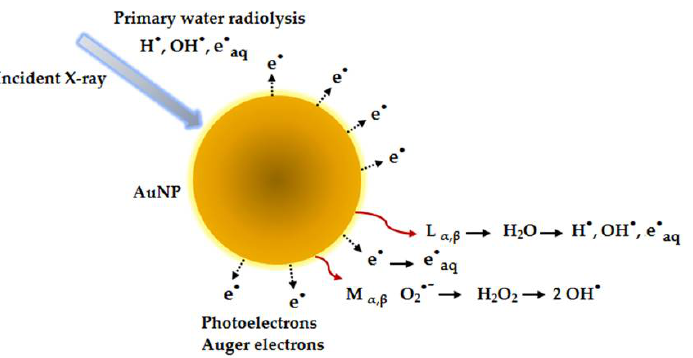
Figure 8. Schematic depiction of increased generation of reactive species by the emission of photo- electrons and Auger electrons from AuNPs in the presence of ionizing radiation.